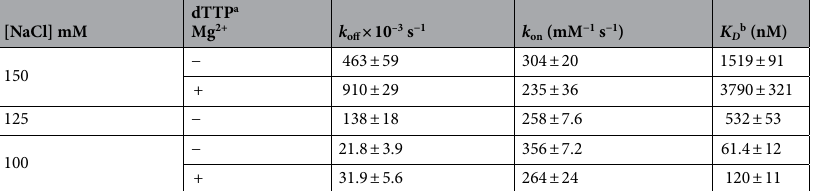
Primer sequence